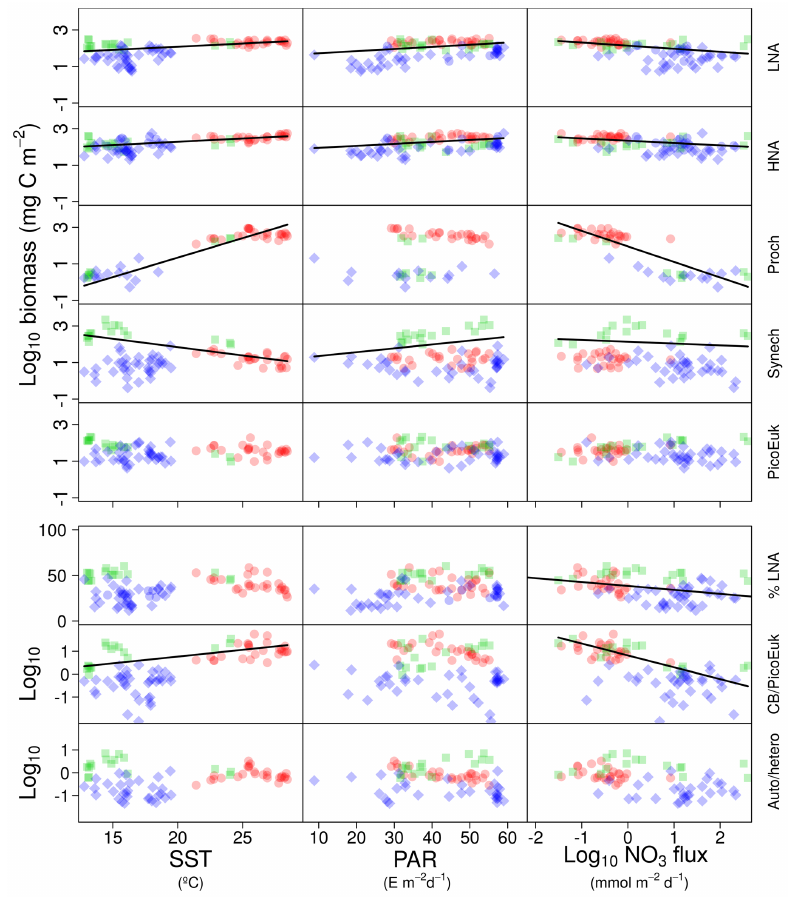
Figure 3. Pair scatter plots representing the relationship among log-transformed depth-integrated biomass for each picoplankton subgroup, the contribution of bacteria with a low nucleic acid content to heterotrophic picoplankton biomass (%LNA), the ratio of cyanobacteria ( Prochlorococcus + Synechococcus ) to picoeukaryote depth-integrated biomass (CB / PicoEuK), and the ratio of autotrophic to heterotrophic picoplankton biomass (Auto / hetero) versus sea surface temperature (SST), surface photosynthetically active radiation (PAR), and nitrate flux (NO 3 flux). Significant linear relationships are indicated as solid ( p value < 0 . 01) black lines. Samples collected at different regions are indicated as red dots (tropical and subtropical Atlantic Ocean), green squares (Mediterranean), and blue diamonds (Galician coastal